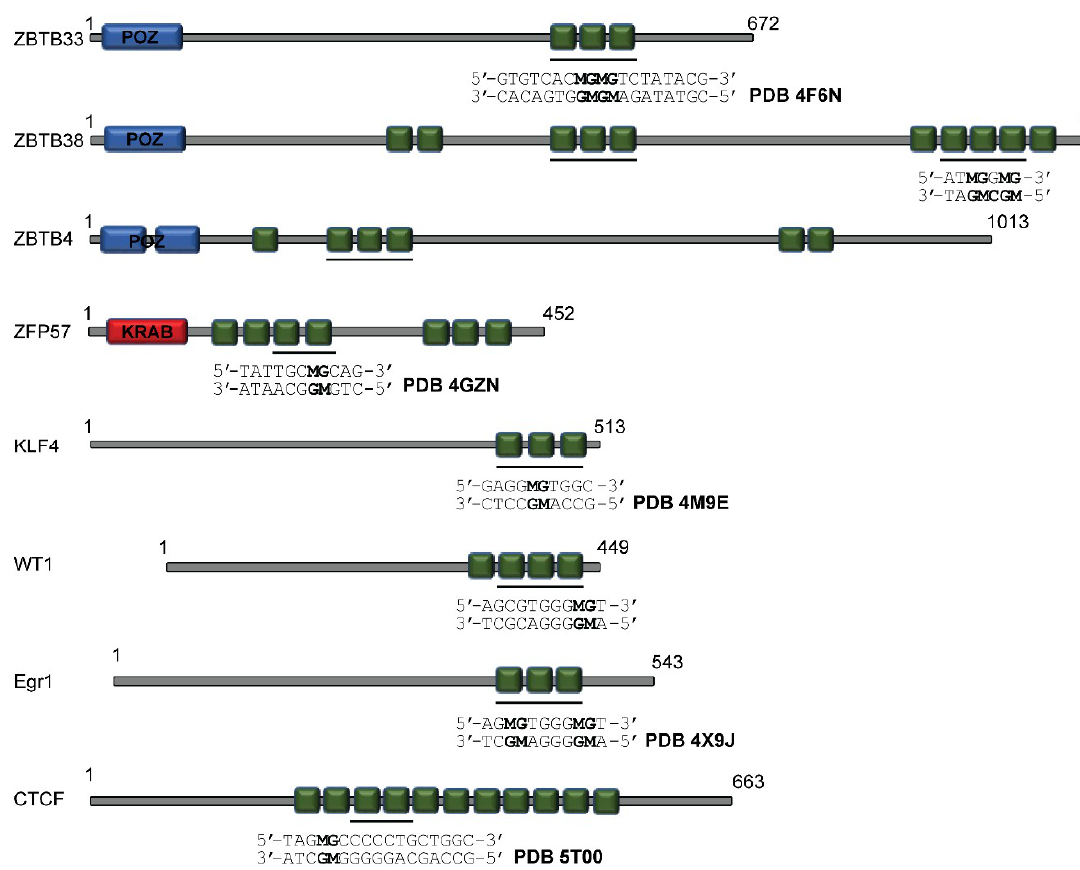
Figure 1. Domain organization for the characterized zinc finger (ZF) methyl-CpG binding proteins (MBPs). For each protein, the ZFs shown to have methyl sensitivity are underlined and the target DNA sequence utilized for high-resolution structural investigations are depicted alongside the Protein Data Bank (PDB) identification for the structures shown in Figure 2. M refers to methylated cytosine. POZ: Pox virus and zing finger domain; KRAB: Krüppel-associated box.